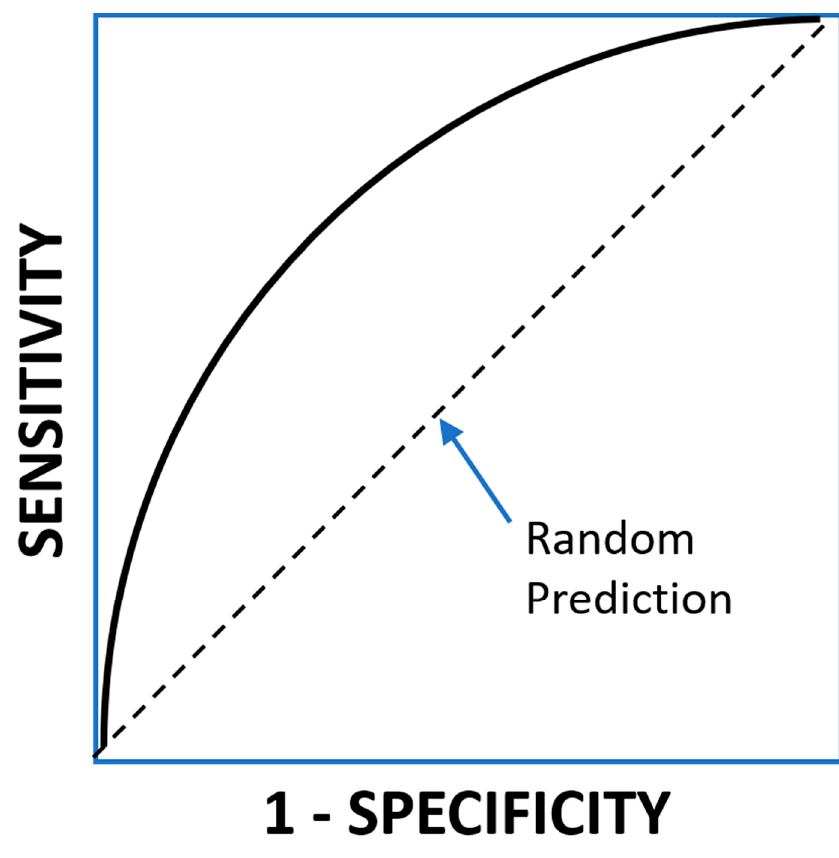
Figure 2. ROC curve of a binary classifier.